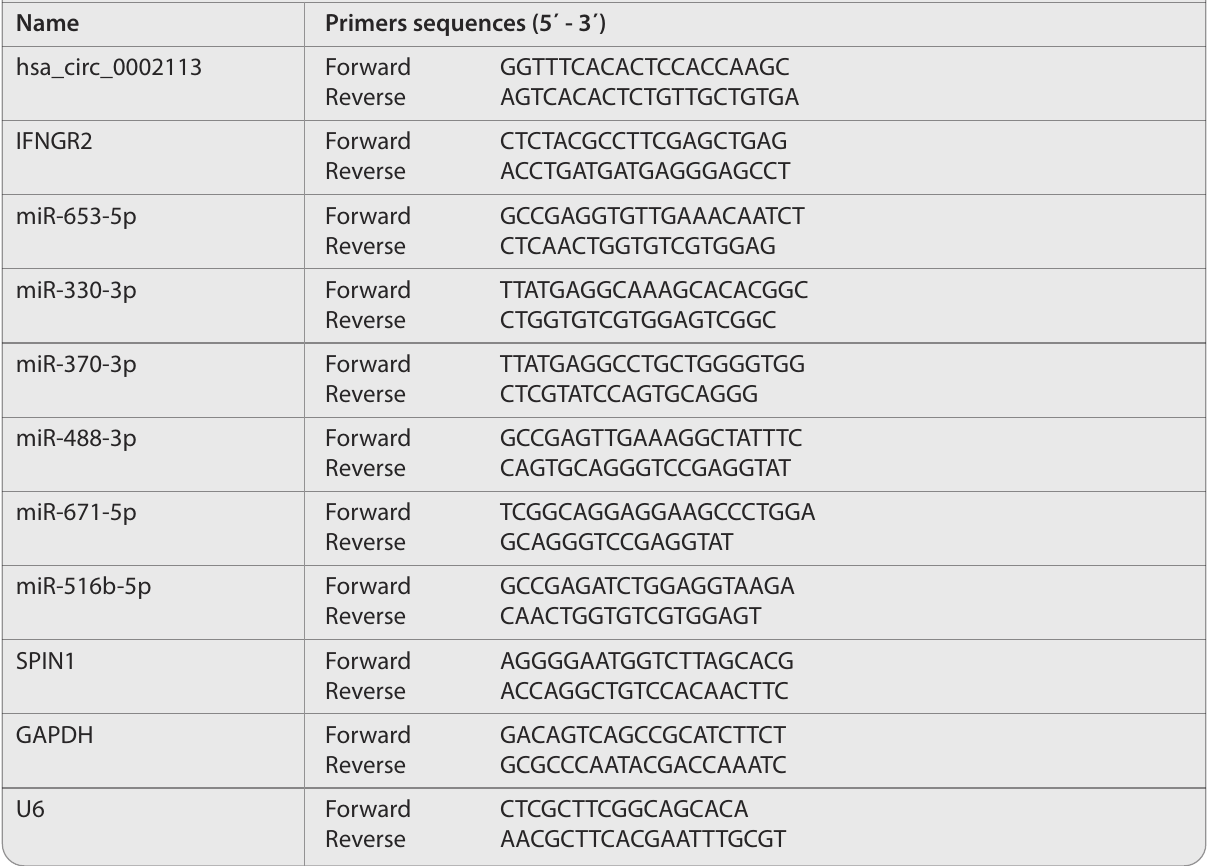
Table 2. Primer sequences used for RT-qPCR